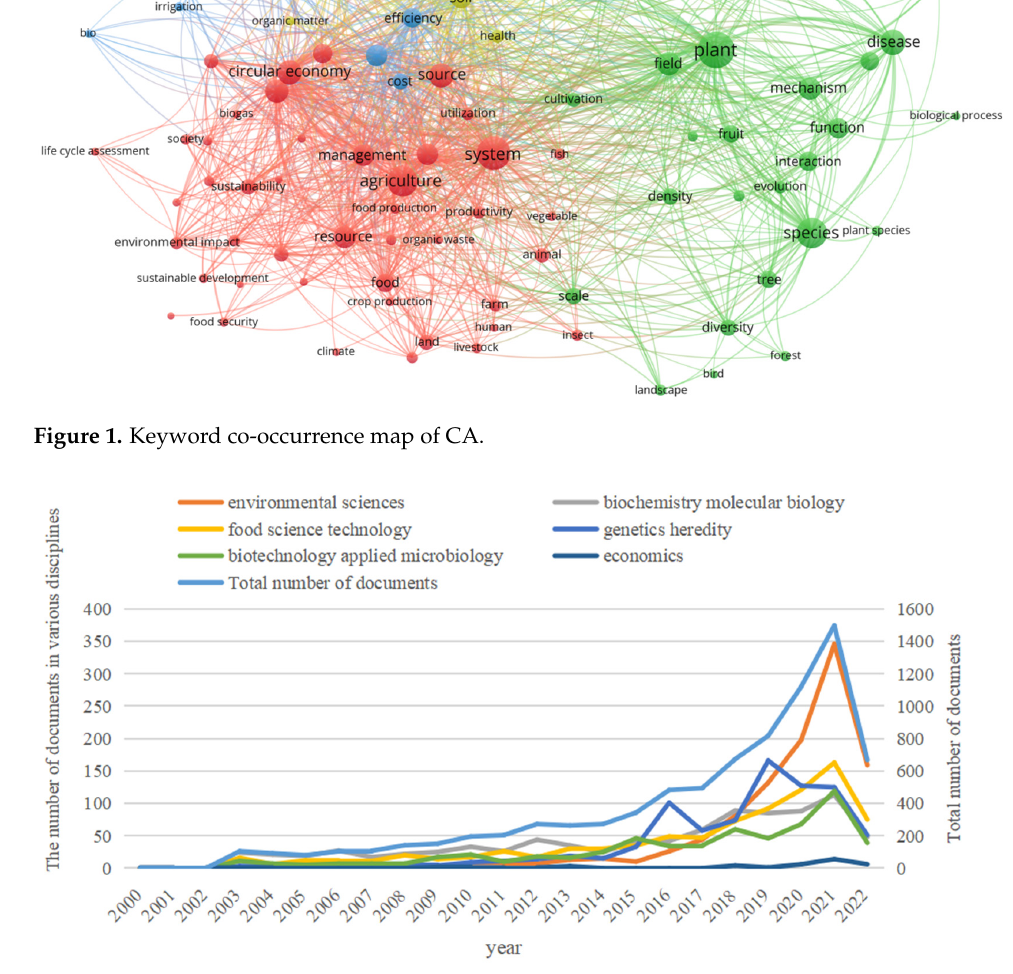
Figure 2. Discipline Distribution of CA research from 2000 to 2022 (June).